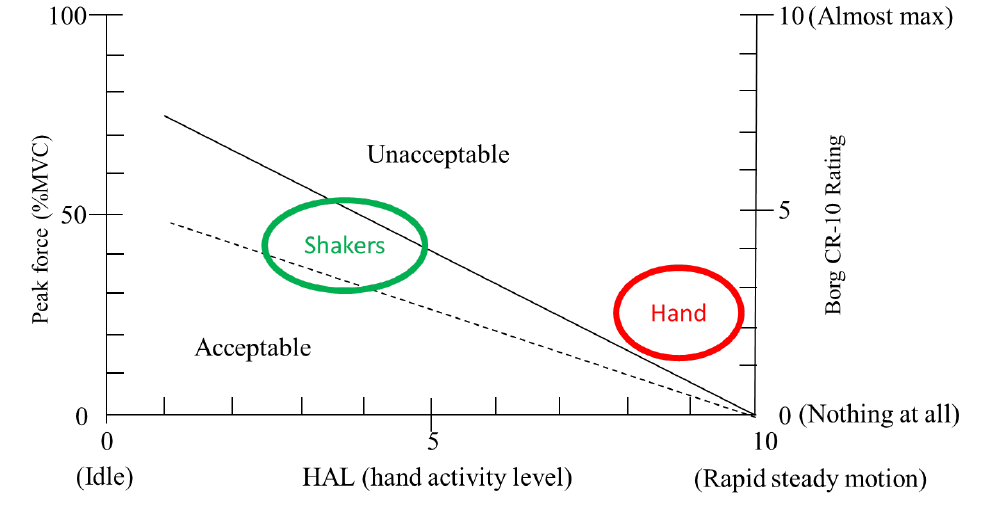
Figure 13. Threshold Level Values for Shakers and Hand Harvesting.